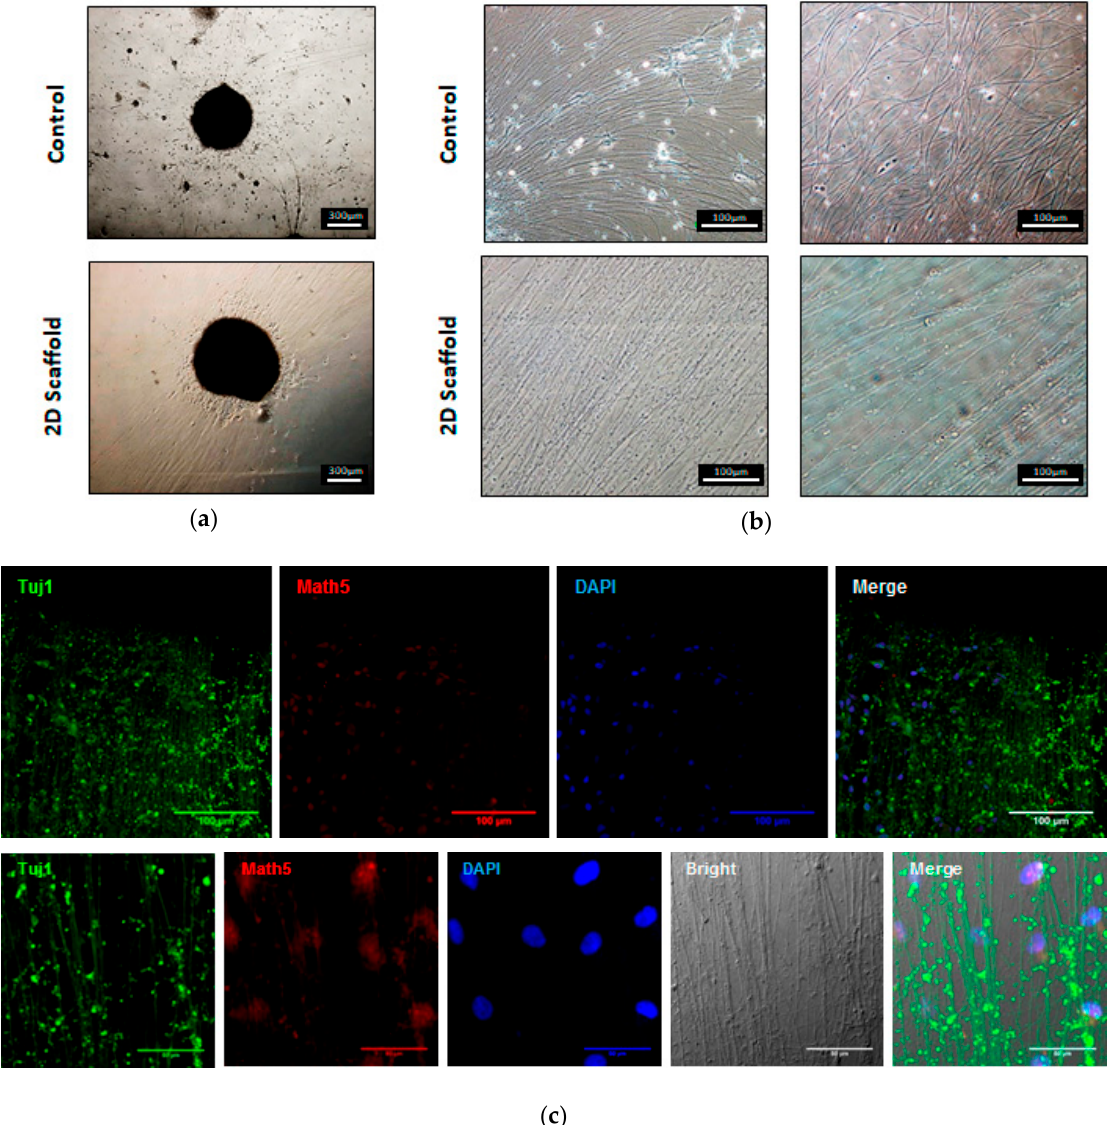
Figure 4. Neurite growth on the EVA scaffold. The OV was placed on a 2D scaffold for 5 days and the nerve bundles were found to grow and had a regular arrangement (( a ) bottom panel ) but were not arranged without a scaffold (( a ) up panel ). Observe the position of the nerve bundle, near the position of the sphere is the proximal (( b ) left panel ) and far away from the sphere of the location that is distal (( b ) right panel ); ( c ) immunofluorescence was used to validate the RGC-specific markers, the expression of Math5, and the markers of the neural cytoskeleton Tuj1. Nerve bundles of Tuj1 and Math5 can be observed at a lower magnification (( c ) up panel , 40×). The neuronal growth pattern was observed with a bright field and the markers of nerve bundles (Tuj1 and Math5) were observed (( c ) bottom panel , 100×).